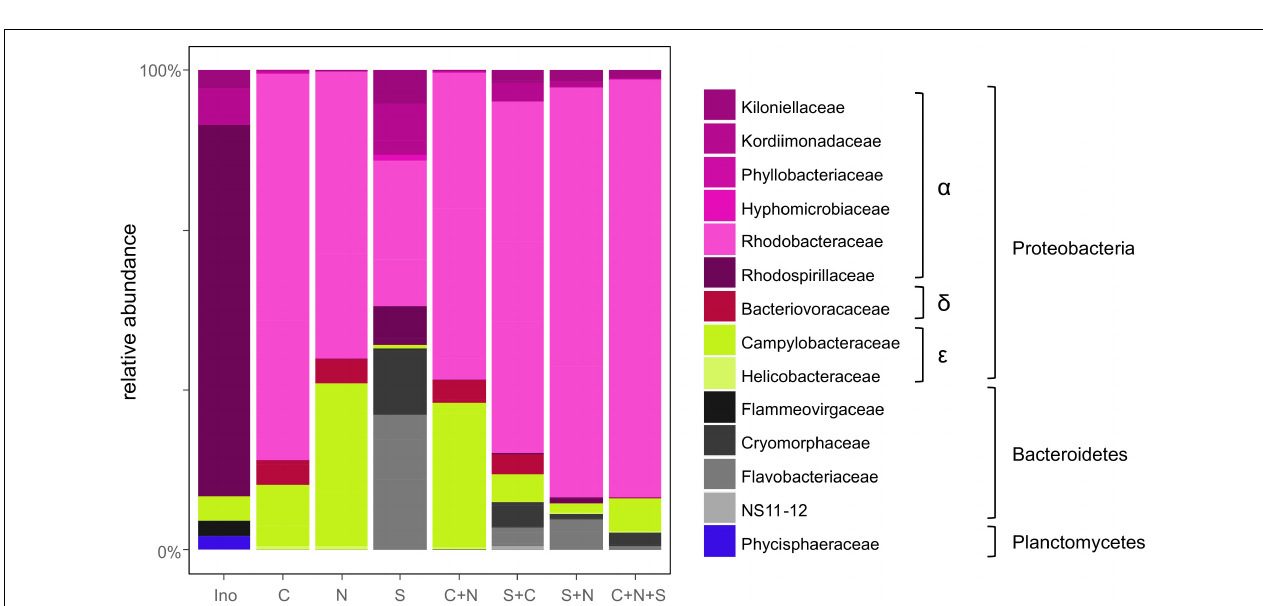
FIGURE 2 | The presence of bacteria steepens the algal diversity-productivity relation. (A) Diatom biovolume production in function of species richness and its slope (m) in the presence (non-axenic, black line) or absence of bacteria (axenic, gray line). (B) Algal biovolume production per diatom species and its slope for each diatom: S. robusta (yellow), C. closterium (red), and N. phyllepta (blue). The presence or absence of bacteria are, respectively depicted as dark- and light-colored lines. The contribution of the selection and complementarity effects to diversity-productivity relation are, respectively shown in (C,D) in the presence (black) or absence (gray) of bacteria.